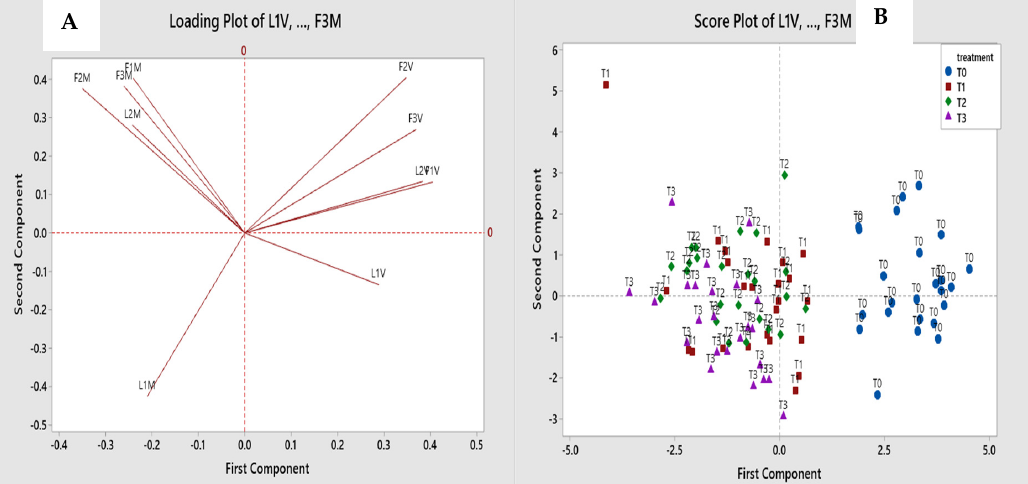
Figure 3. Comparison of mortalities (M) and survival rates (V) during two larvae stages of P.ziziphi (L1V: Surviving larvae of stage 1; L1M: Dead larvae of stage 1; L2V: Surviving larvae of stage 2; L2M: Dead larvae of stage 2).